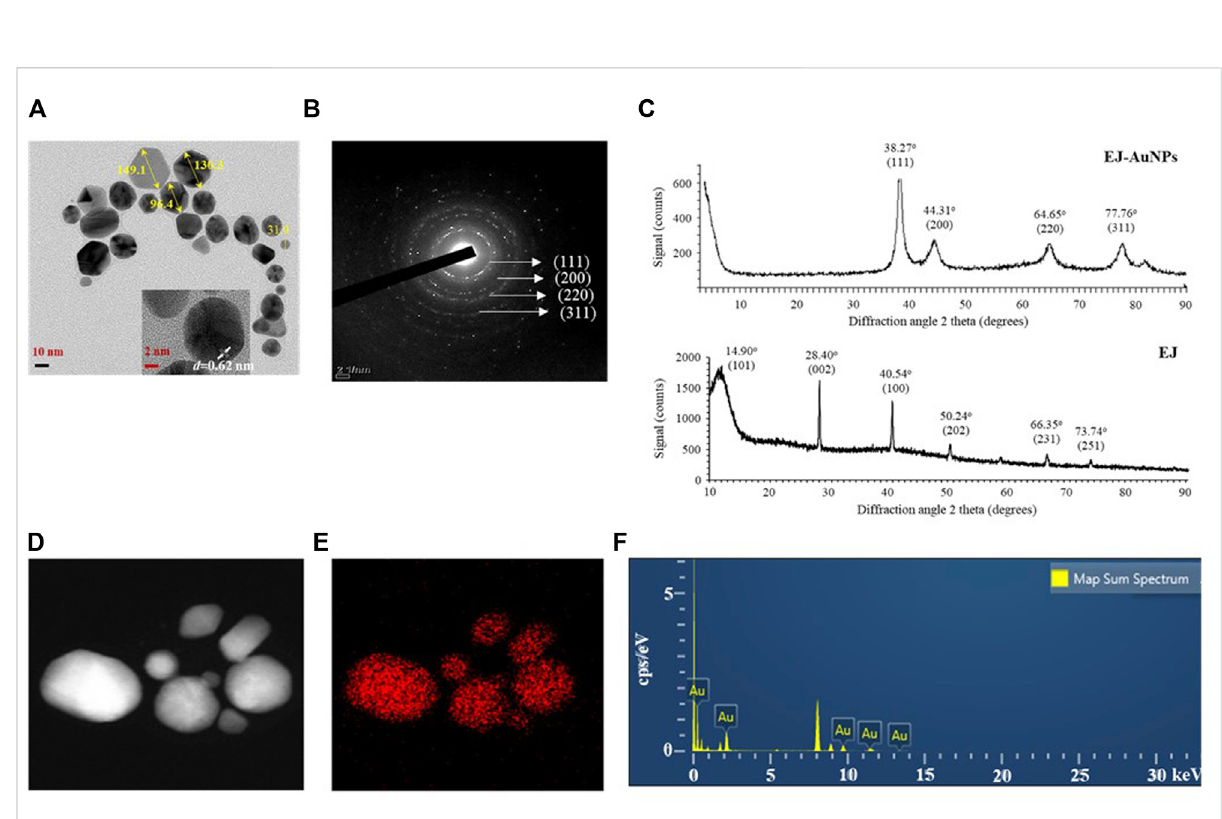
FIGURE 5 Physicochemical characteristics of EJ-AuNPs. (A) Transmission electron microscopy (TEM) for determining the surface morphology and particle sizes of EJ-AuNPs. (B) Selected area electron diffraction (SAED) pattern and (C) X-ray diffraction (XRD) spectrum for determining the crystalline structure of EJ-AuNPs and EJ. (D) Electron images of EJ-AuNPs obtained by energy dispersive X-ray (EDX) analysis. (E) Gold elemental distribution (red dots) of EJ-AuNPs obtained by EDX analysis. (F) EDX spectrum of EJ-AuNPs for identifying elemental